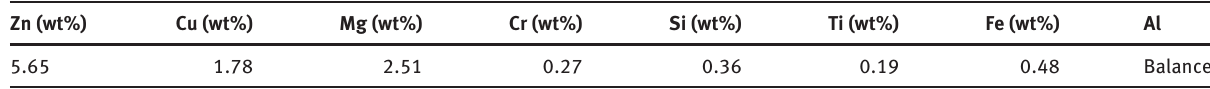
Table 1: Composition of aluminum alloy